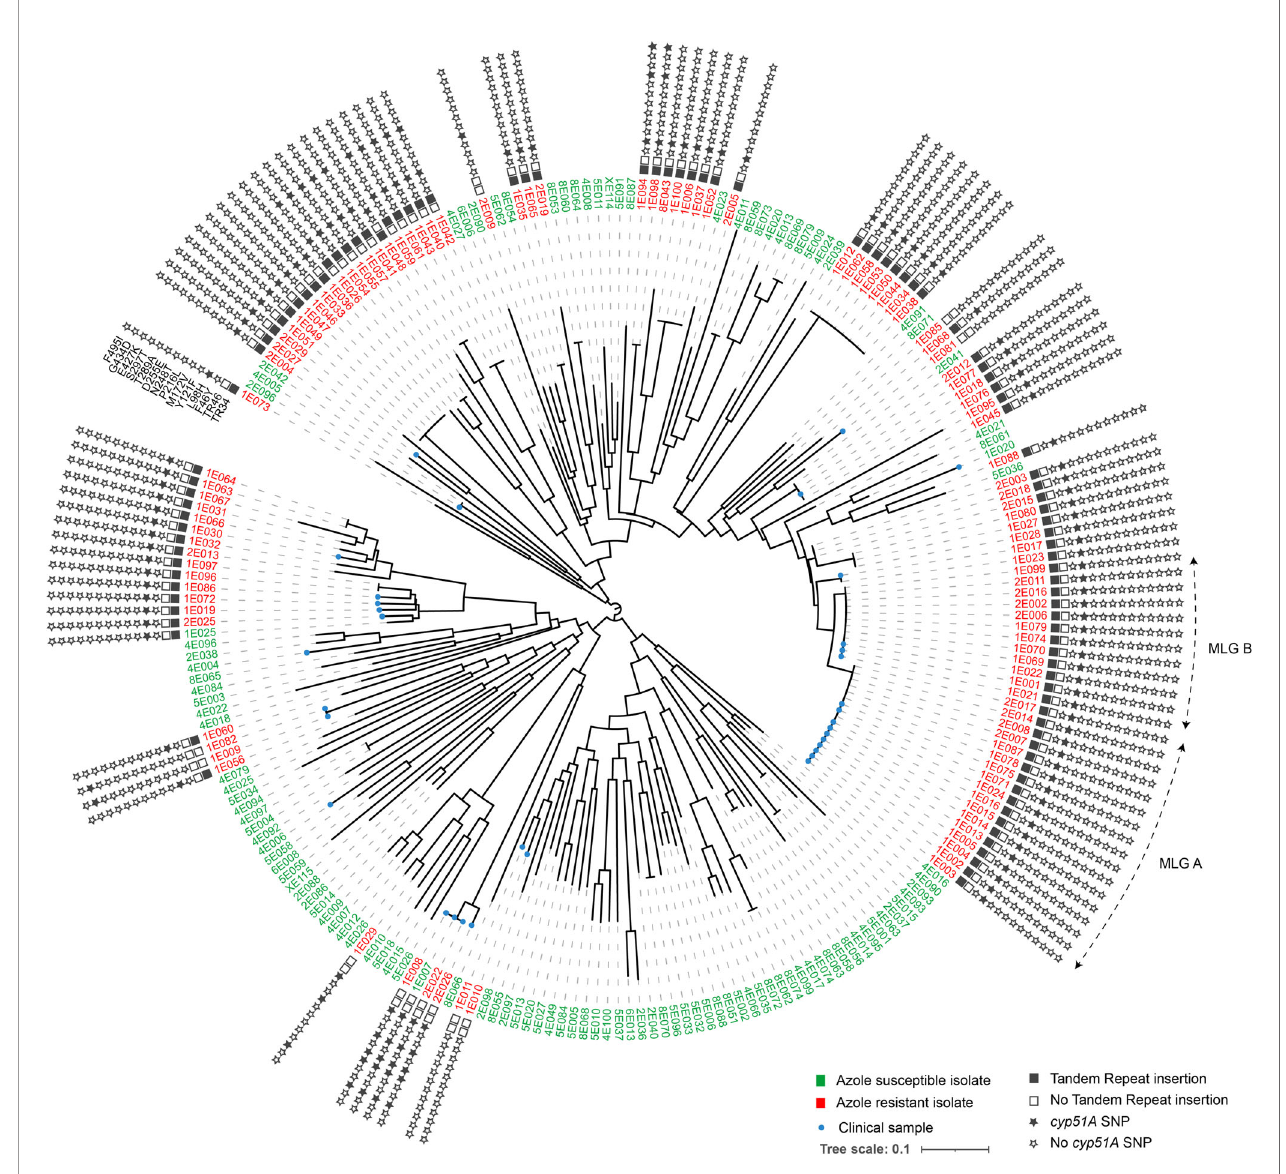
FIGURE 2 | Circular dendrogram illustrating relationship among 113 azole-resistant (with details of tandem repeat and cyp51A SNP) and 112 azole-susceptible Aspergillus fumigatus , isolated from clinical or environmental samples. Genetic relationships are based on short tandem repeat at nine loci, using Bruvo ’ s distance and Neighbor-Joining clustering. The two most common multilocus genotypes (MLG) are denoted by the letters A and B Numbers are ID isolates. The stars provide information on the TR or SNP present on the cyp51A gene.